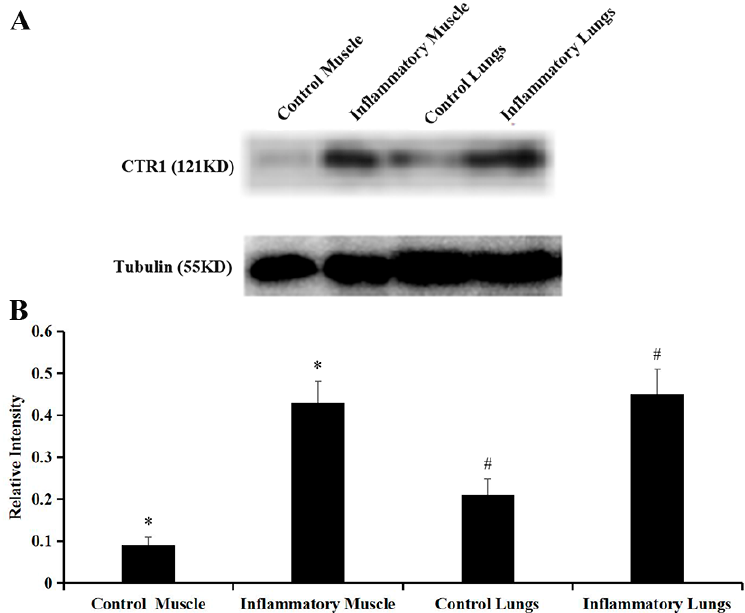
Figure 4. ( A ) Western blot analysis of CTR1 levels of the control and inflammatory muscle and lung tissues; ( B ) Quantification of the results of western blot analysis (* p = 0.000 control muscle vs. inflammatory muscle; # p = 0.003 control lungs vs. inflammatory lungs).